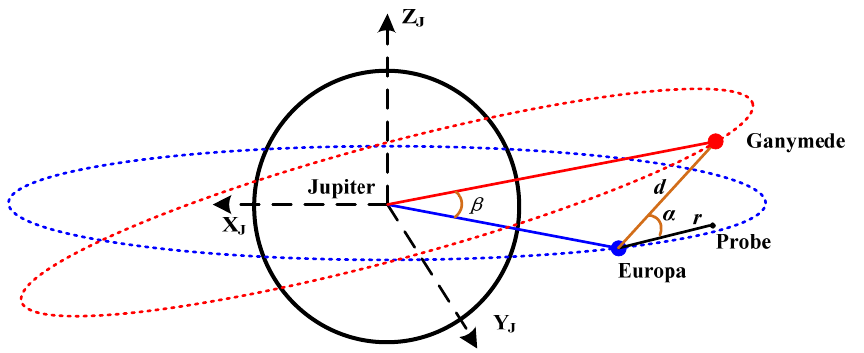
Figure 2. Positions of the planet, moons, and the probe.